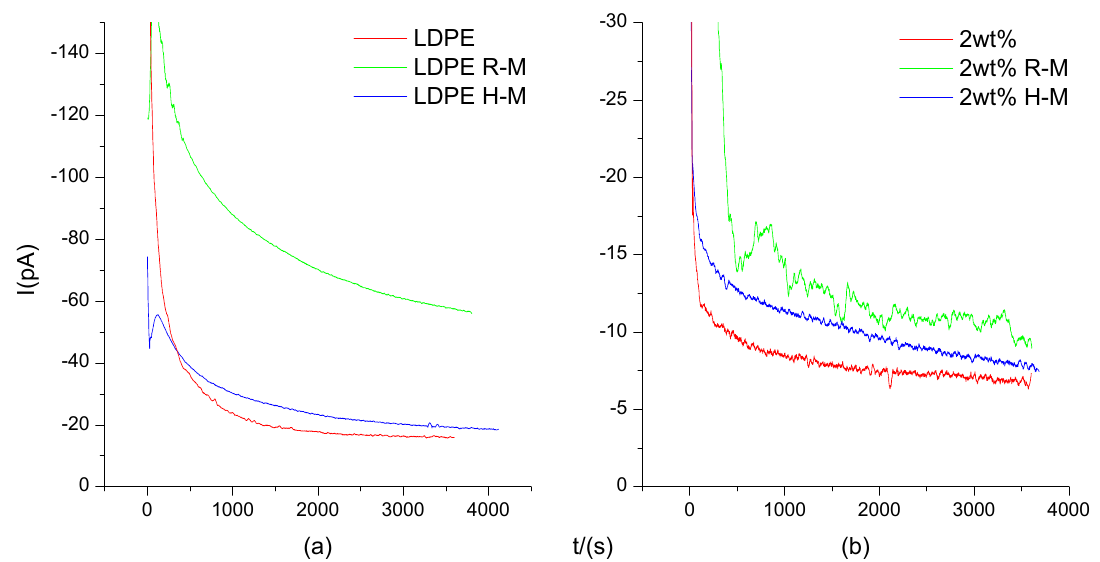
Figure 7. I-t characteristic curve of LDPE ( a ) and composites ( b ) under a 10 kV/mm electric field strength and different magnetization temperatures. ( a ) is the I-t characteristic curve of LDPE. ( b ) is the I-t characteristic curve of BiFeO 3 /LDPE composite. Curves LDPE and 2wt% indicate no magnetization treatment. R-M is room temperature magnetization. H-M is high temperature magnetization.